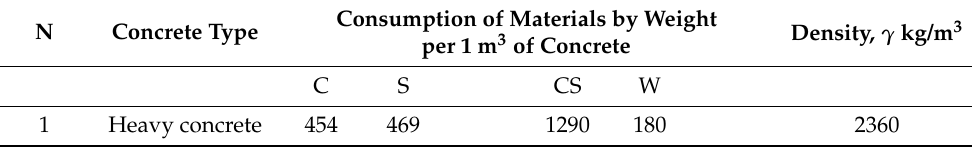
Table 1. Materials consumption for concrete preparation.